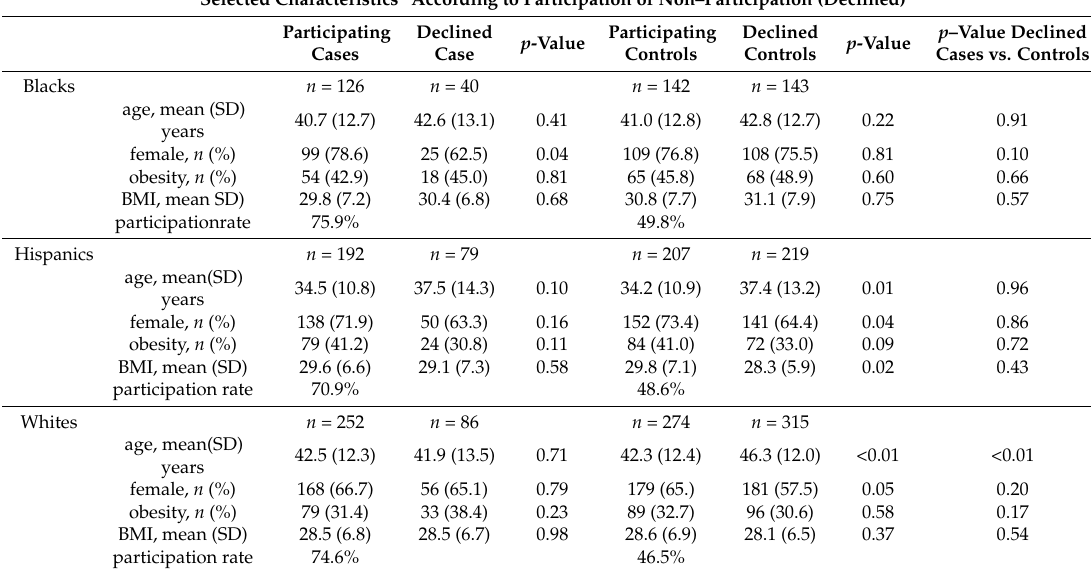
Table A1. Participation rates and comparison of participating and declined participants. Selected Characteristics* According to Participation or Non–Participation